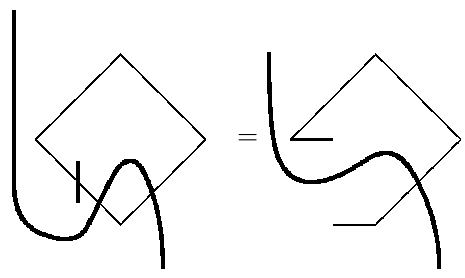
Figure 9 . Contributions to A (2)